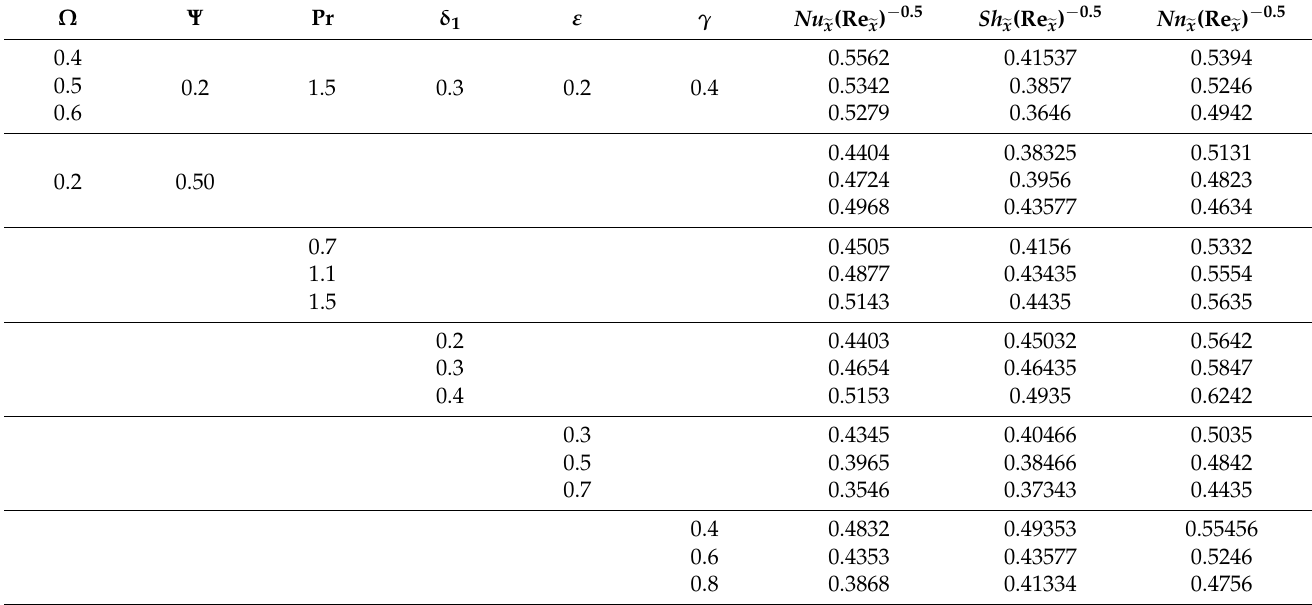
( Re ) − 0.5 , Sh (cid:101) x (cid:101) x